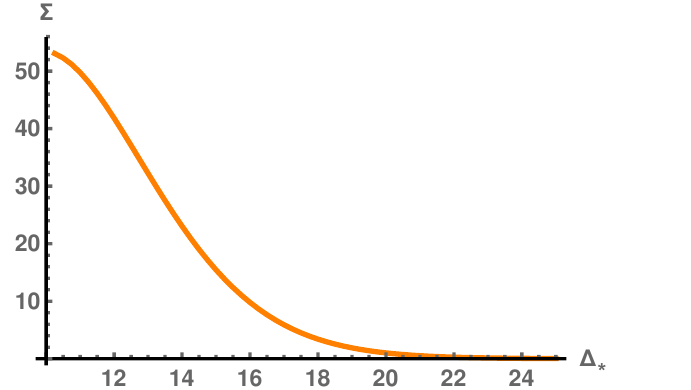
Figure 3. The estimate (cid:6)((cid:1) (cid:3) ) as a function of (cid:1) (cid:3)